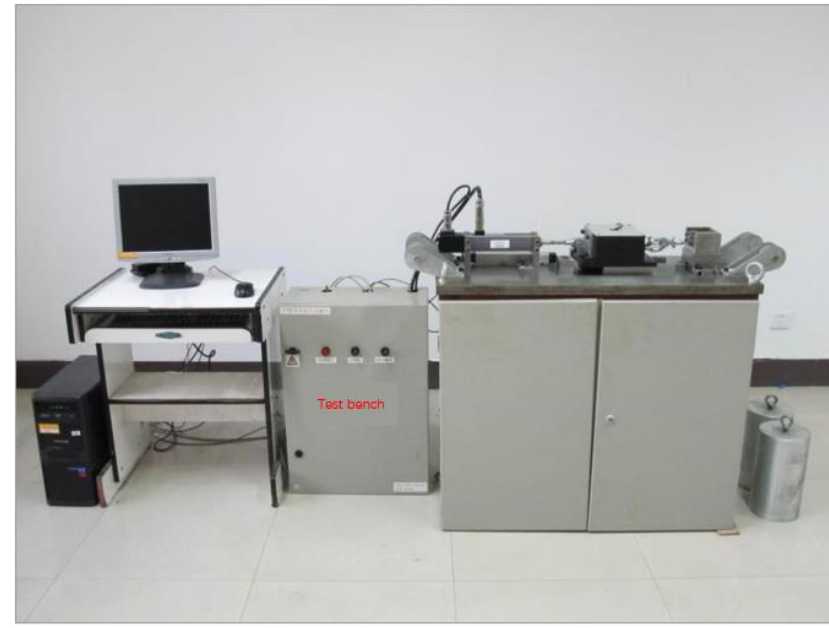
Figure 11. Overall structural diagram of the experimental platform.